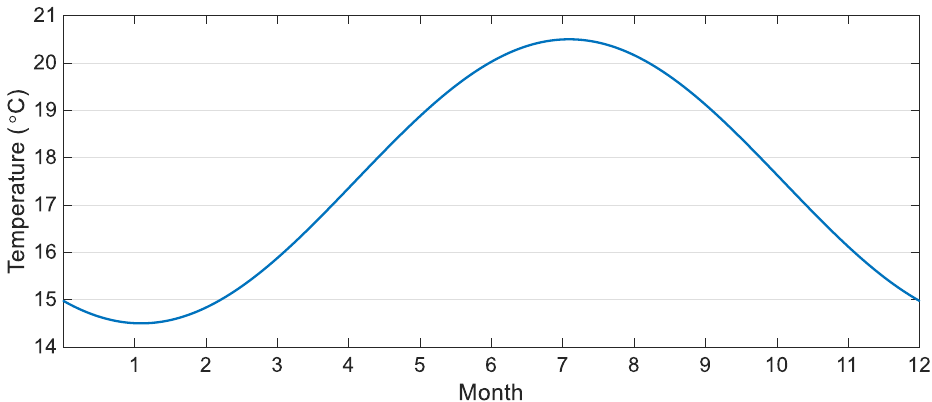
Figure 7. Annual profile of the inlet groundwater temperatures of the flow to the PDHX container.